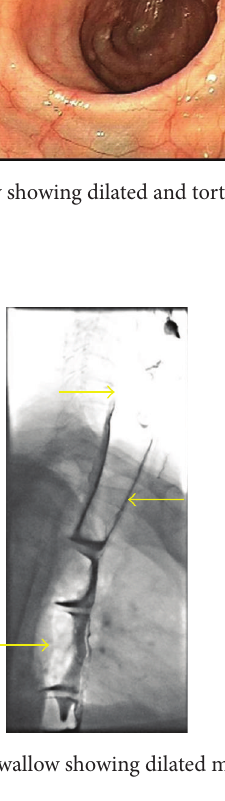
Figure 3: Barium swallow showing dilated